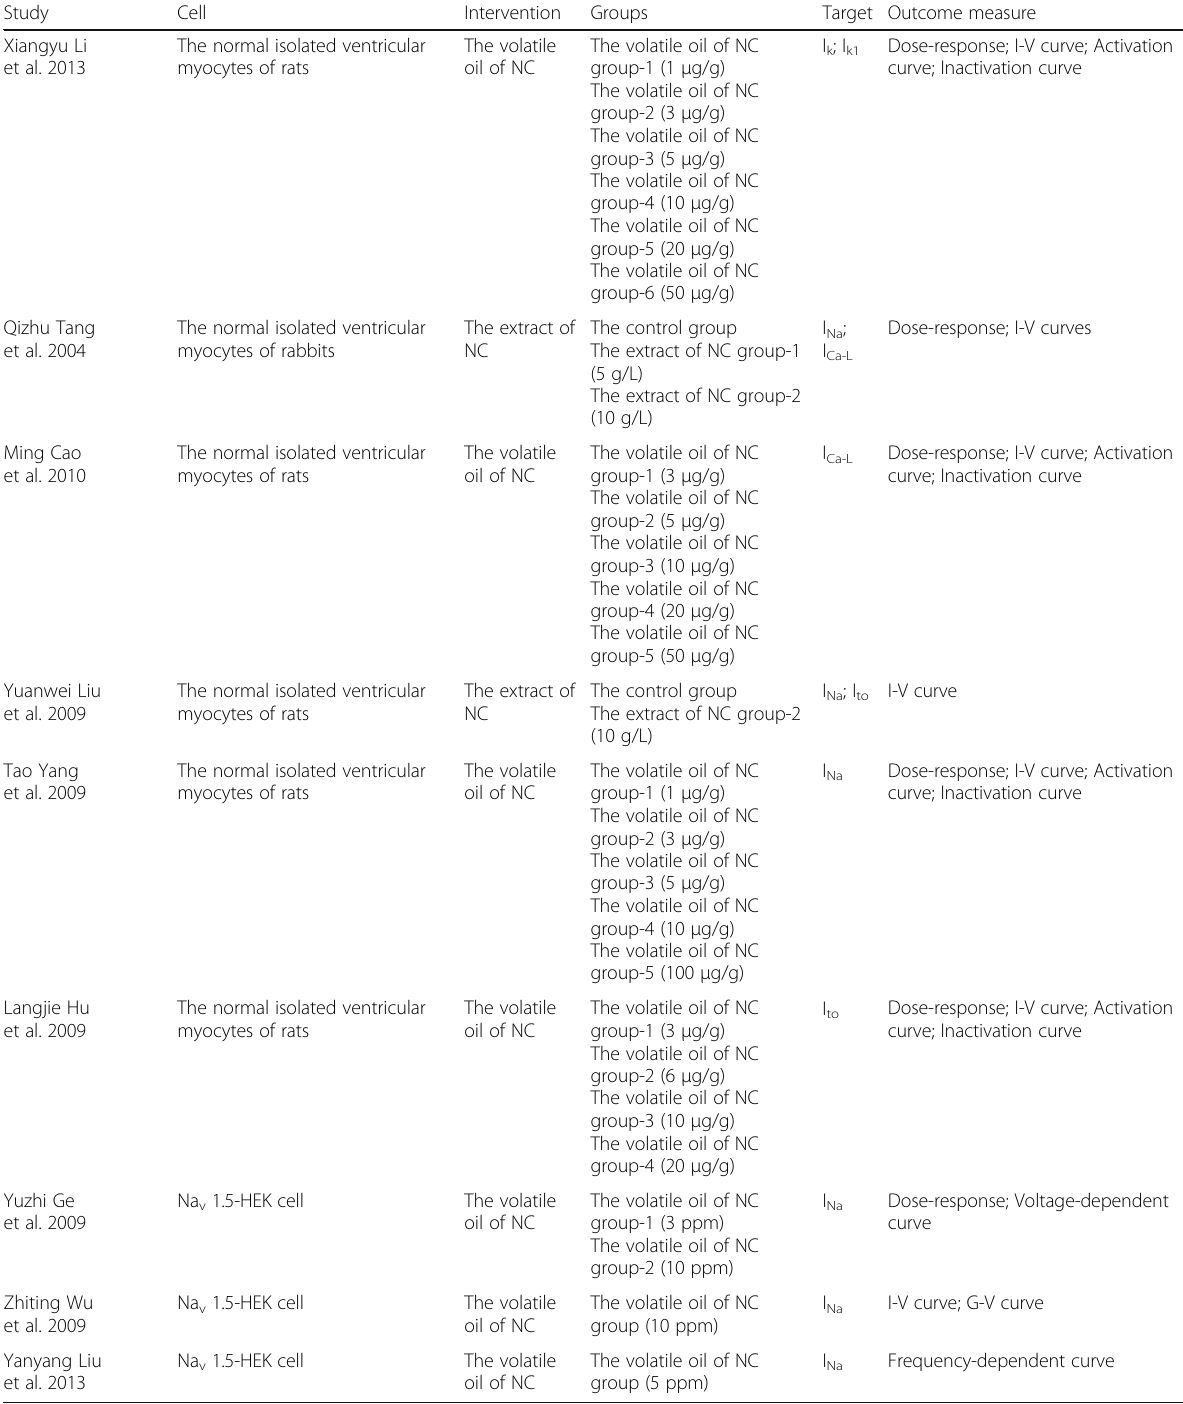
Table 2 The detailed information of the cell experiments